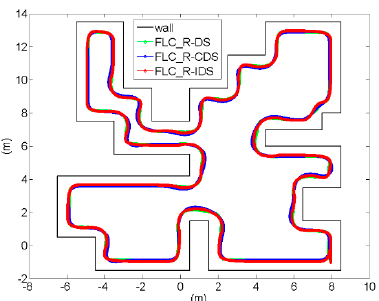
Figure 11. ( a ) Mobile robot path tracking, ( b ) ultrasonic sensors values, and the left-wheel and right- wheel speeds of the robot in the test environment 2 for the FLC_R-IDS method.